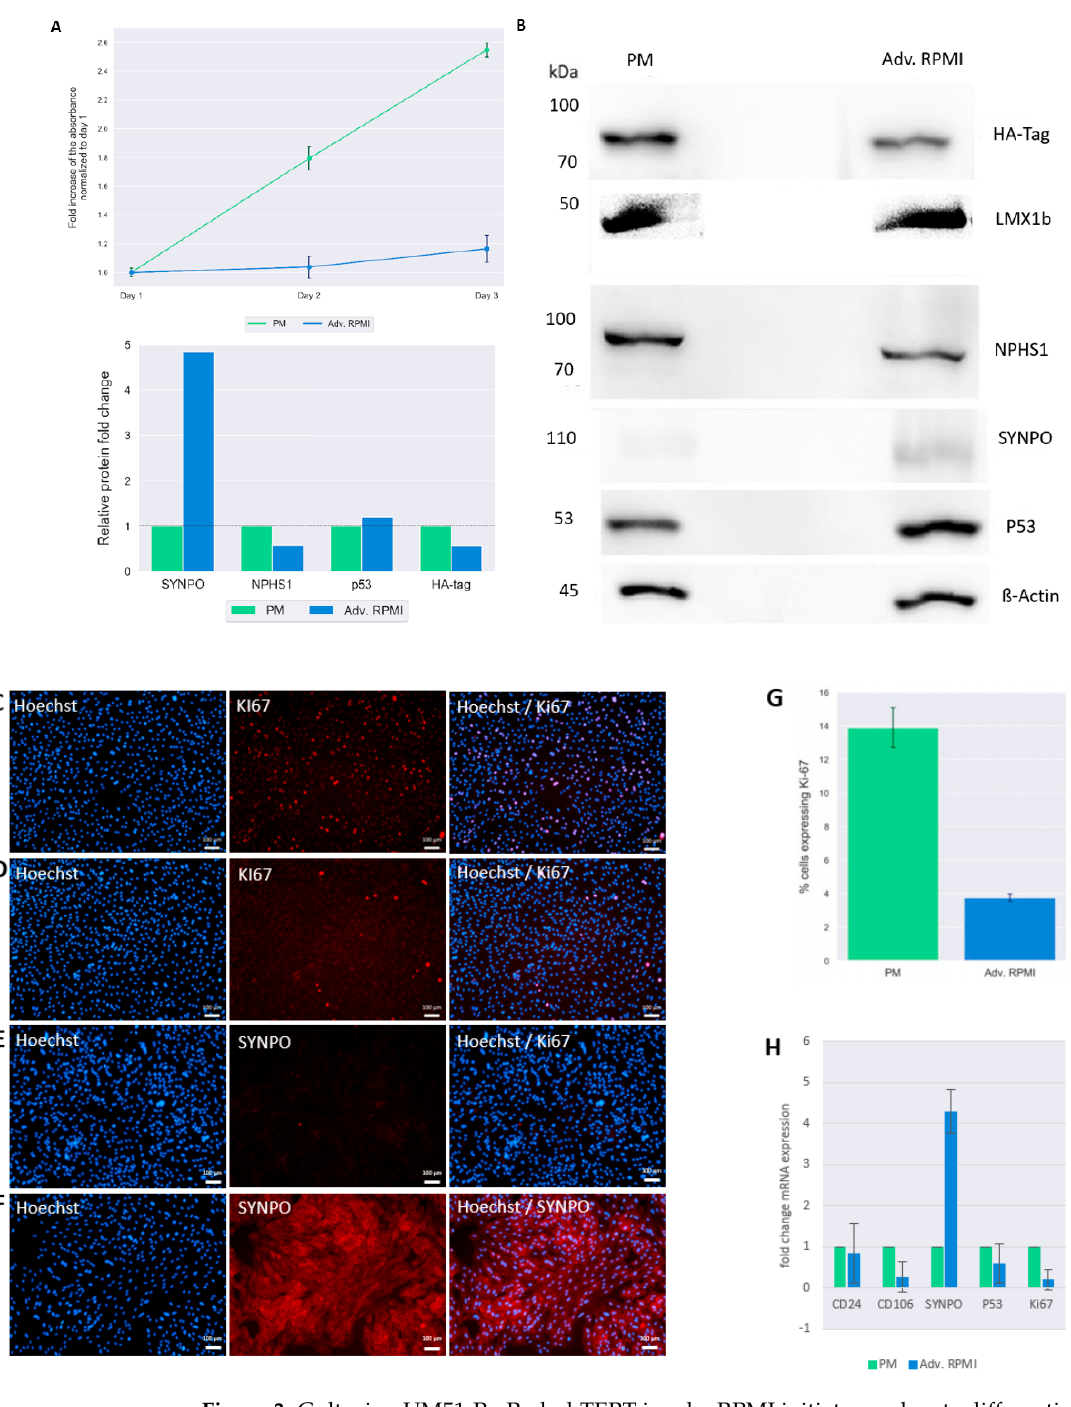
Figure 3. Culturing UM51-PrePodo-hTERT in adv. RPMI initiates podocyte differentiation. Proliferation of immortalized UM51-PrePodo-hTERT cells cultured in PM and adv. RPMI medium was assessed by a resazurin assay ( A ). Relative protein expression normalized to ß-ACTIN for the HA-tag, LMX1B, NPHS1, SYNPO and P53 was detected by Western blot ( B ). Ki-67 and SYNPO expression in UM51-PrePodo-hTERT cultured in PM and adv. RPMI were detected by immunofluorescence-based staining ( C – F ). Immunofluorescence-based detection of UM51-PrePodo-hTERT cells grown in PM are given in ( C , E ), while cells grown in adv. RPMI are given in ( D , F ) (scale bars: 100 µ m). Percentage of UM51-PrePodo-hTERT cells cultured in proliferation medium and advanced RPMI expressing the proliferation marker Ki-67 is given in ( G ). mRNA expression of CD24, CD106, SYNPO, P53 and KI67 was determined by quantitative real-time PCR ( H